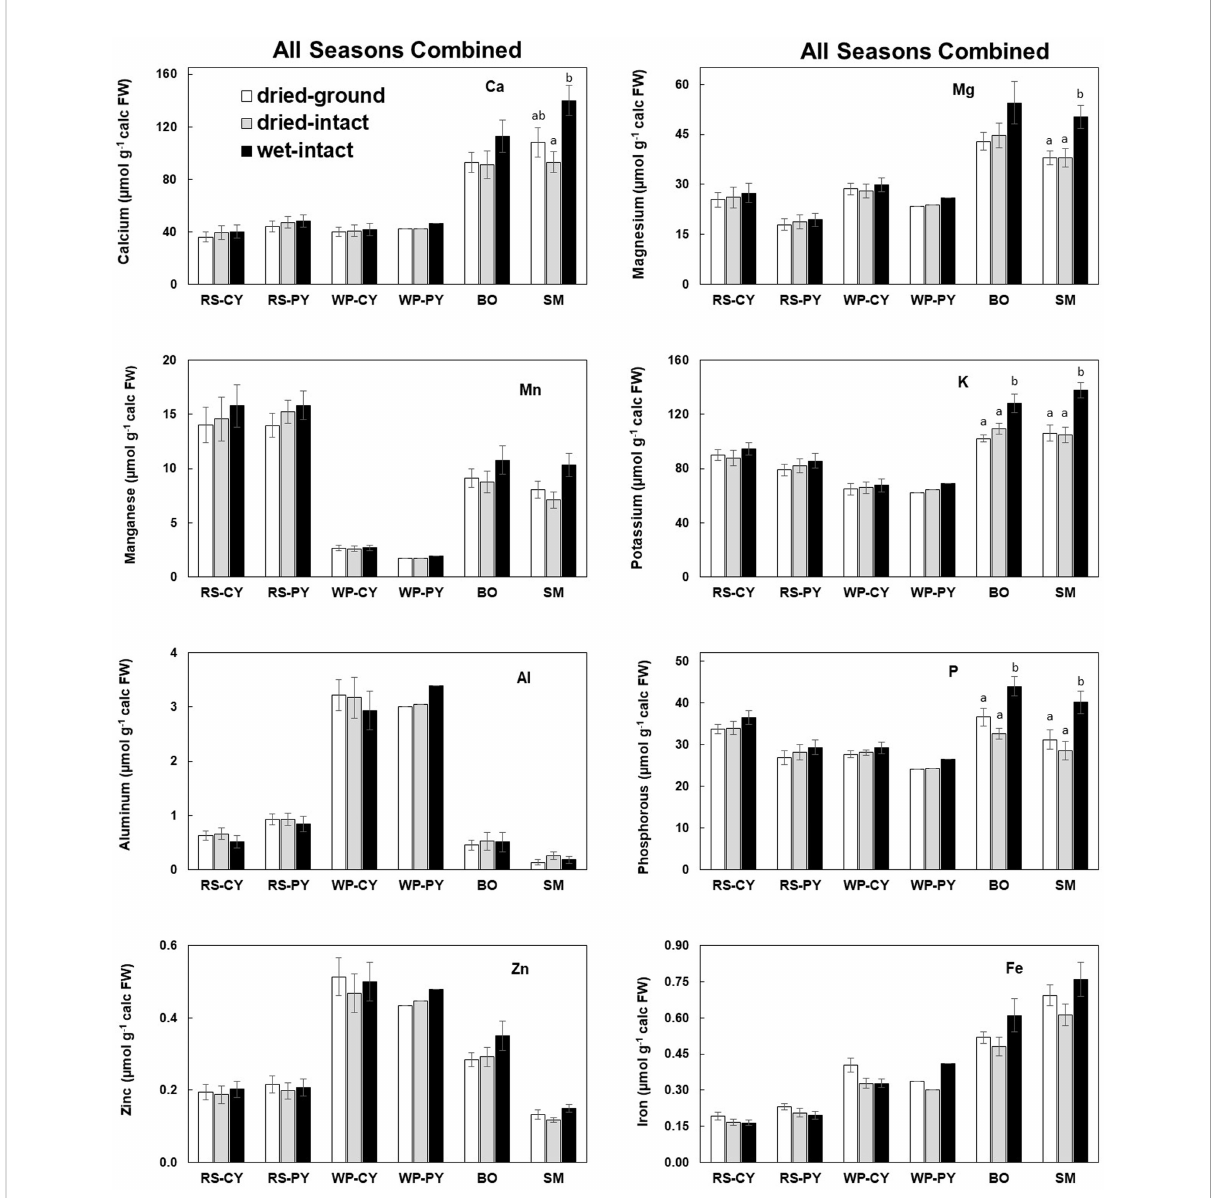
FIGURE 1 Comparison of three methods of tissue preparation for extraction of total inorganic nutrients from red spruce, white pine, black oak, and sugar maple foliage. Data in each bar are mean ± SE of all samples collected from all seasons during 2014-2015 (six times for conifers and four times for hardwood trees). Replicate numbers for each species across all dates are presented in the order: dried-ground/dried-intact/wet-intact: CY- RS, PY-RS, and CY-WP = 13/10/13; PY-WP = 1/1/1; BO = 9/6/9 and SM = 11/7/11. Letters on top of the bars indicate signi fi cant differences among the three methods for each species. P ≤ 0.05. CY stands for Current-Year foliage and PY for